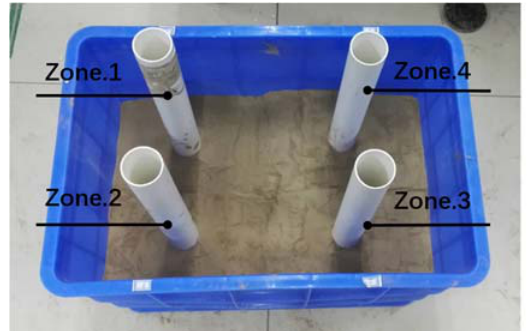
Figure 4. A soil tank with a four ‐ tube array installed in ‐ situ.